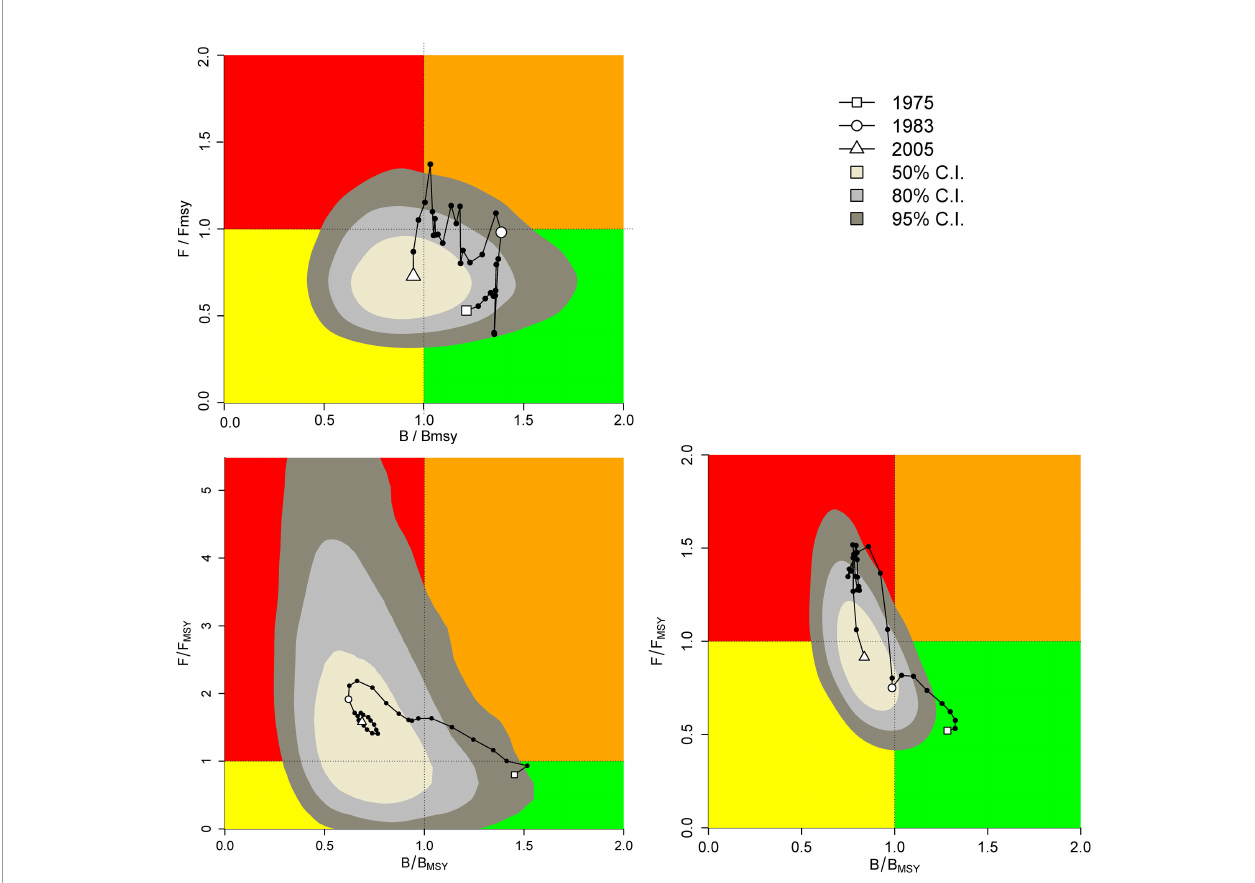
FIGURE 3 | Kobe plots of stock biomass status (x-axis) and exploitation (y-axis) using CMSY (upper on the left), AMSY (lower on the left), and BSM (lower on the right) for the southern Atlantic albacore ( Thunnus alalunga ) fi shery. The plot is divided into four quadrants, de fi ned for the stock biomass and fi shing mortality relative to B MSY and F MSY , respectively. The orange area indicates healthy stock sizes that are about to be depleted by over fi shing. The red area indicates that the stock is over fi shed and is undergoing over fi shing, with biomass levels being too low to produce maximum sustainable yields. The yellow area indicates reduced fi shing pressure on stocks recovering from still too low biomass levels. The green area is the target area for management, indicating sustainable fi shing pressure and a healthy stock size capable of producing high yields close to MSY. The “ banana ” shape around the assessment of the fi nal year triangle indicates uncertainty with yellow for 50%, gray for 80%, and dark gray for 95% con fi dence levels. CMSY, Monte Carlo Catch-maximum sustainable yield model; AMSY, abundance-based maximum sustainable yield method; BSM, Bayesian state-space Schaefer